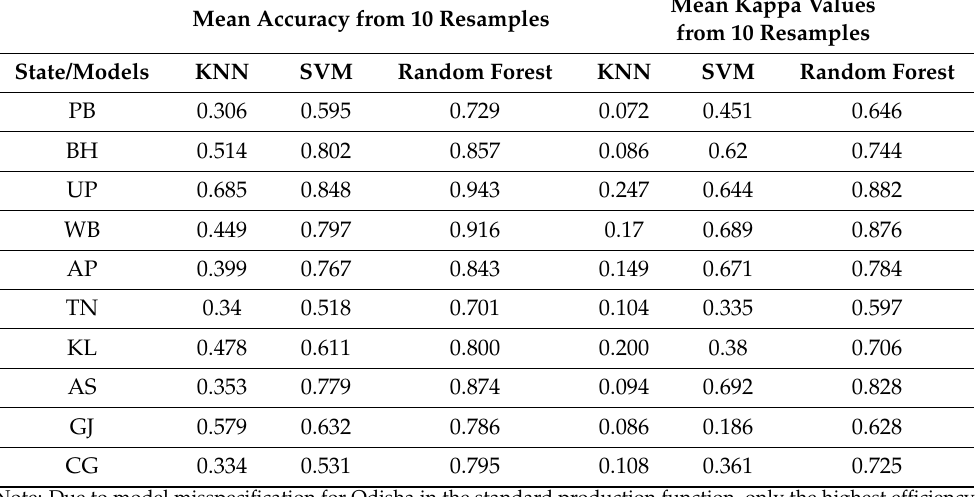
Table 8. Comparison of the KNN, SVM and random forest algorithms for their accuracy in classifying efficiency groups in paddy production across major paddy-producing states of India in AY